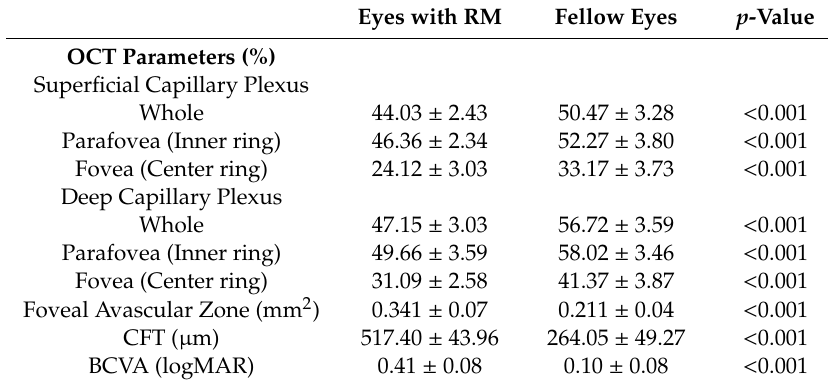
Table 2. Di ff erences in OCT angiography vessel density, central foveal thickness, and BCVA between the eyes with radiation maculopathy (before intravitreal injections) and their fellow